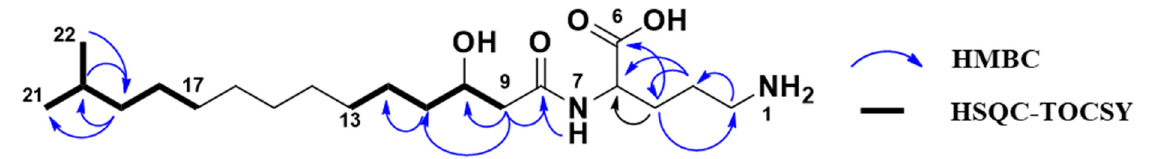
Figure 4. Selected 2D NMR correlations obtained for 1 .